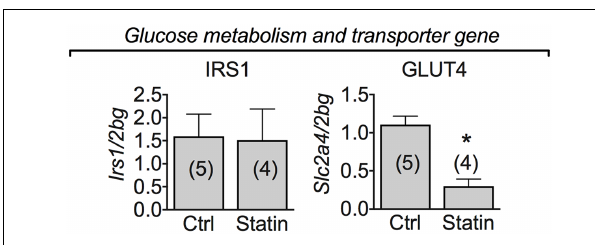
FIGURE 7 | Real-time PCR analysis of mRNA expression level of genes involved in glucose metabolism and transporter genes in VL muscle biopsies of patients in therapy with statin showing sign of myopathy. Histograms show quantification of transcript levels for IRS1, and GLUT-4 normalized by the beta-2 microglobulin gene. In each graph, the bars represent the mean values ± SEM in myopathic subjects (Statin) compared with those of untreated subjects (Ctrl) from the number of subjects indicated in brackets. ∗ Significantly different with respect to the own control ( P < 0.05) by Student’s t